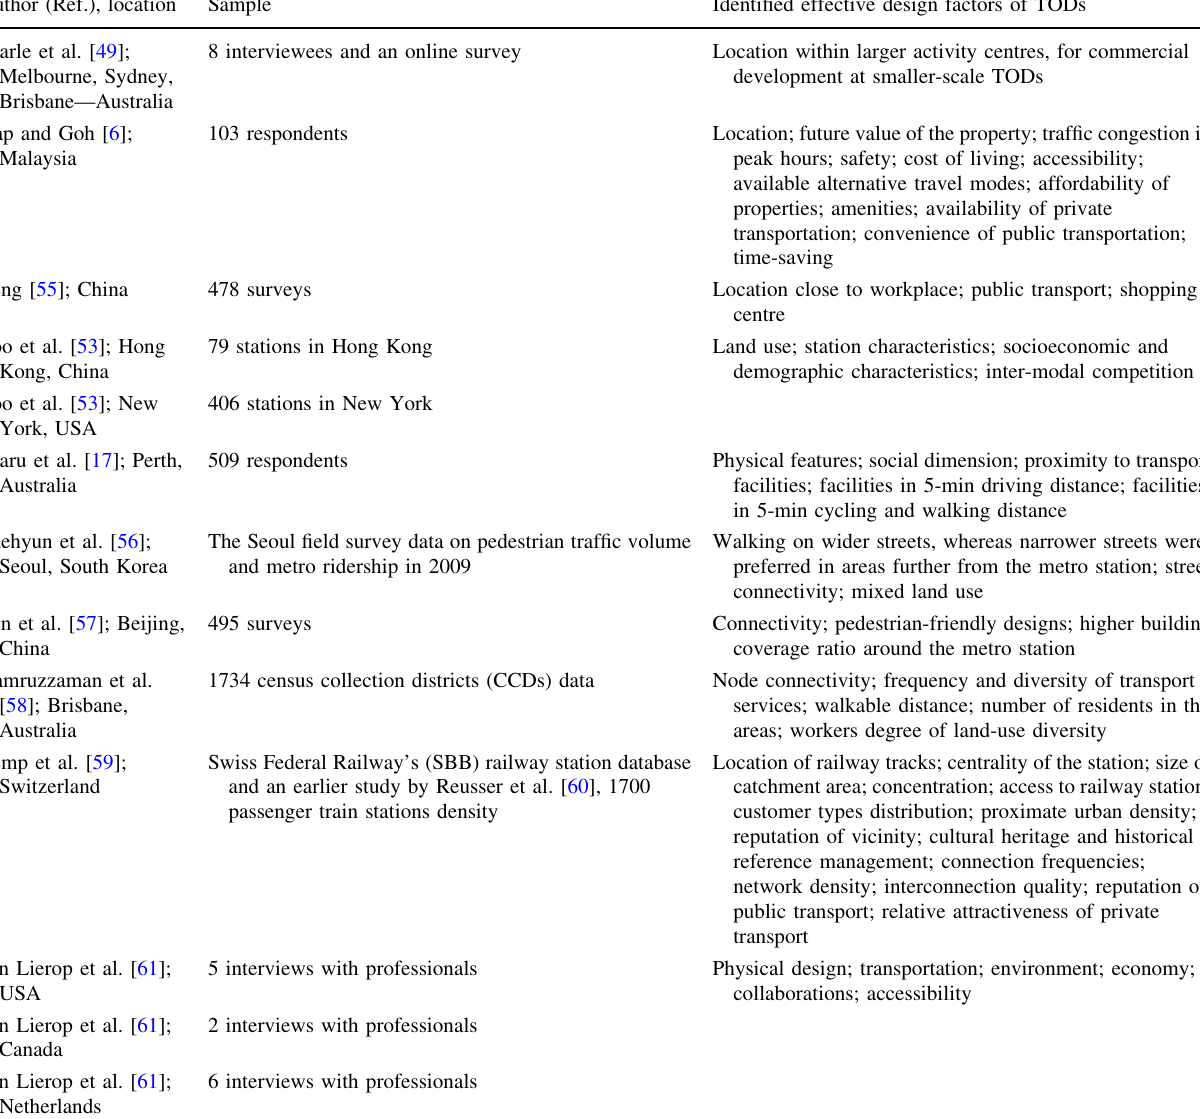
Table 3 Studies in different countries on effective design factors of TODs Author (Ref.),